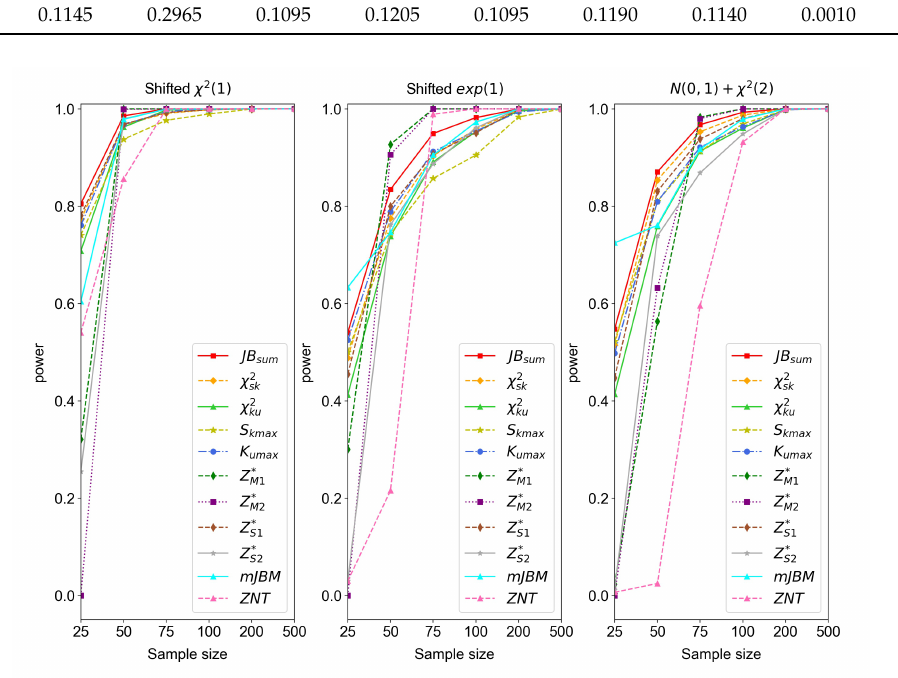
Figure 2. Empirical power of proposed PC-type JB testing compared with other methods ( p =